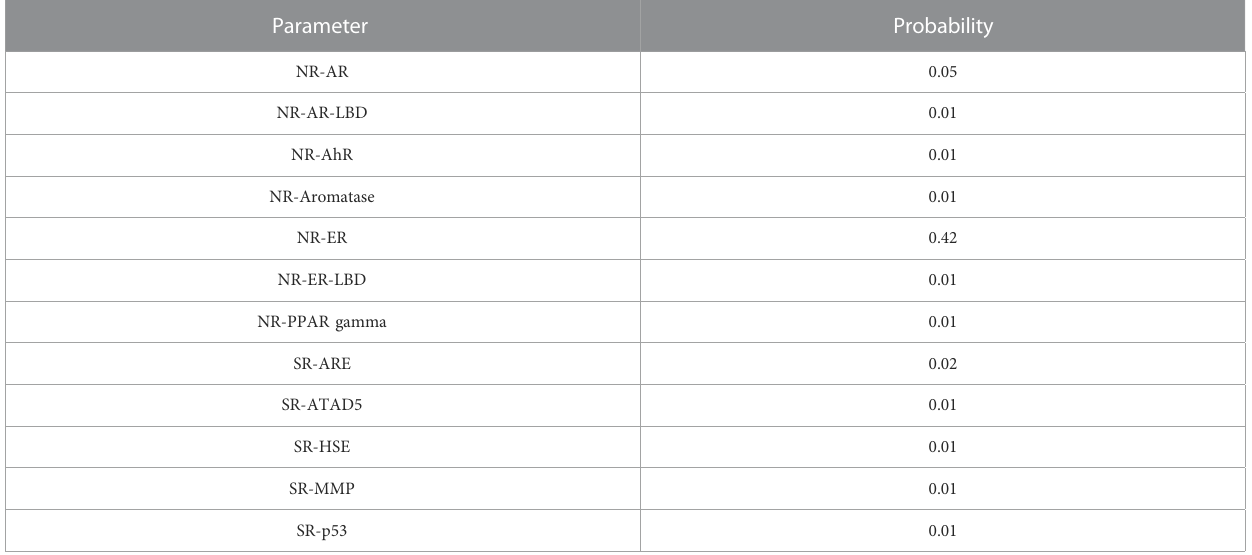
TABLE 6 Toxicity pro fi le of 4-hydroxyisoleucine calculated with ADMETLab 2.0.